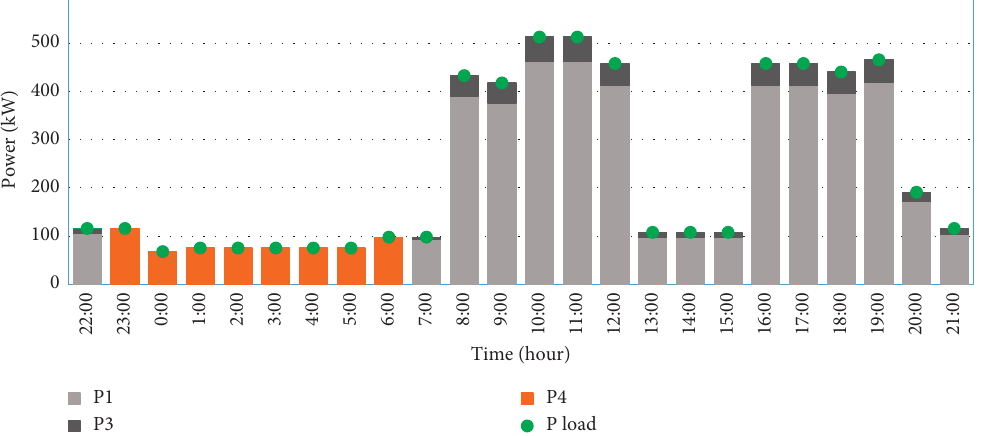
Figure 10: Injected power to the load by different resources in case 4.